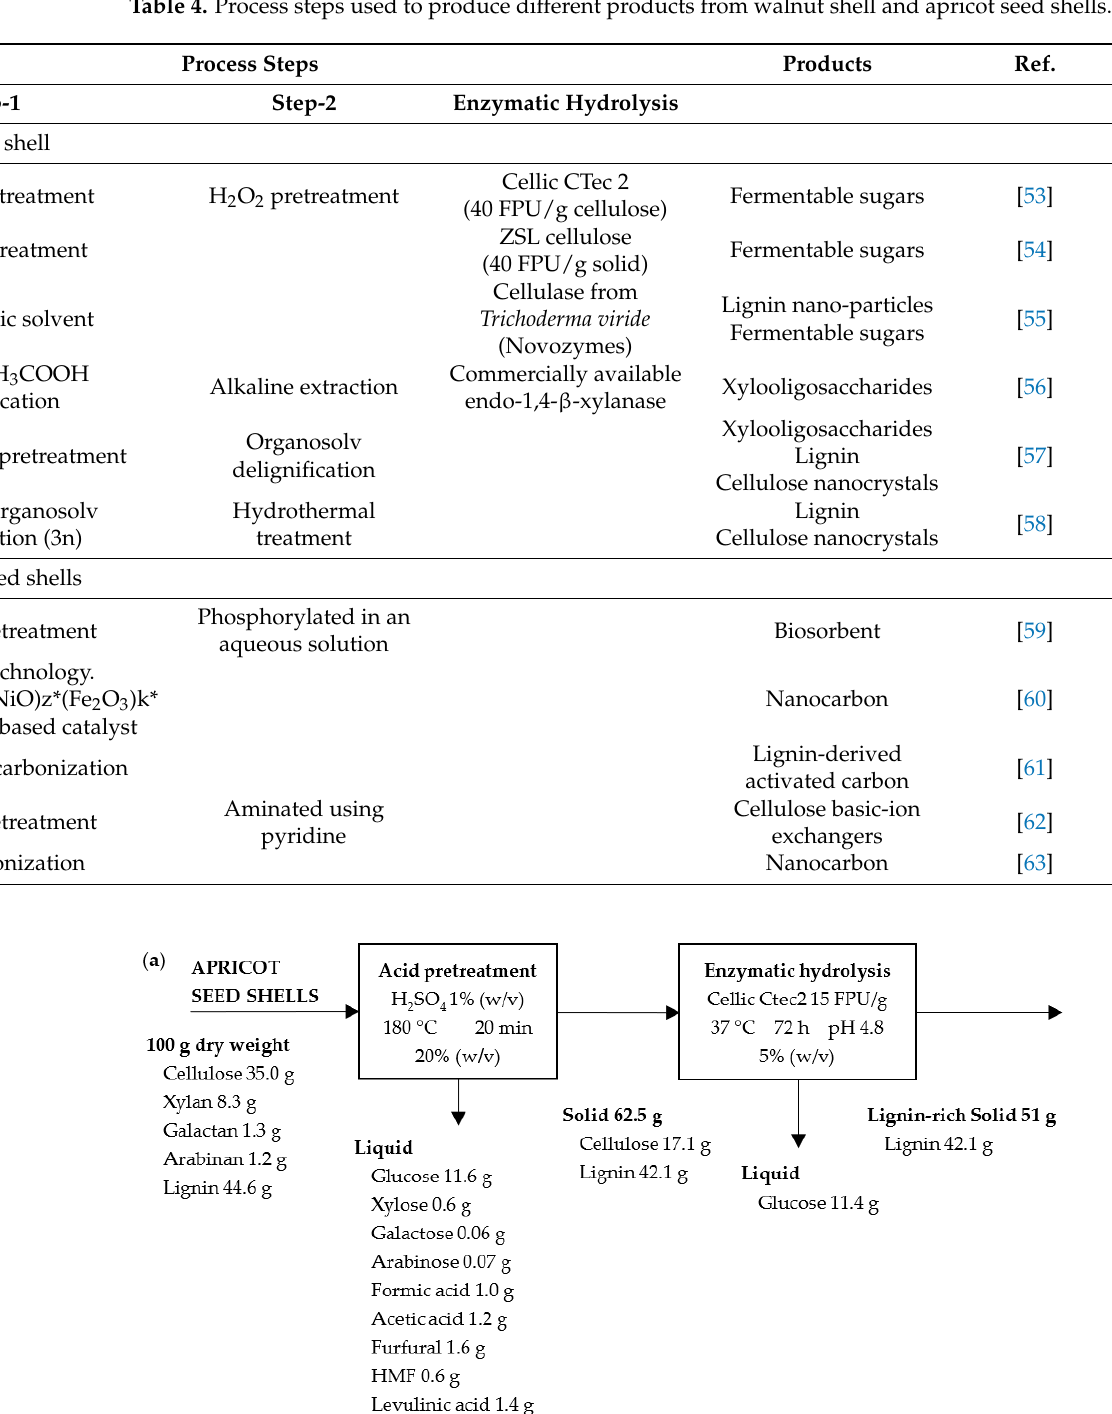
Table 4. Process steps used to produce different products from walnut shell and apricot seed